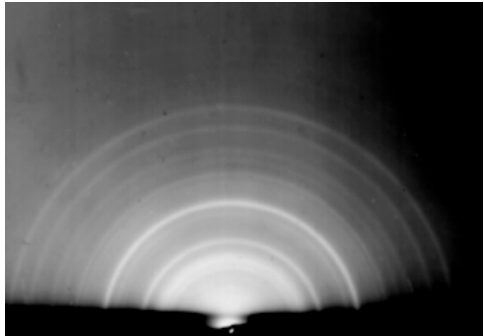
Figure 10. RHEED pattern of polycrystalline 2H-SiC deposited on polycrystalline AlN on silicon at 1570 K, 50 K/s, 60 s, 0,005 % propane, and Si/C = 0,5.